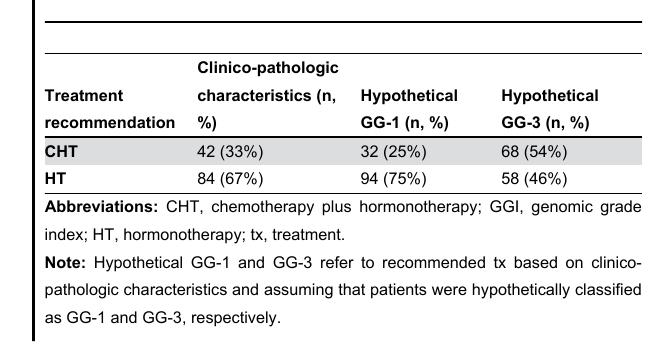
Table 3. Treatment recommendation based on hypothetical GGI results for patients diagnosed with ER-positive and HER2-negative breast